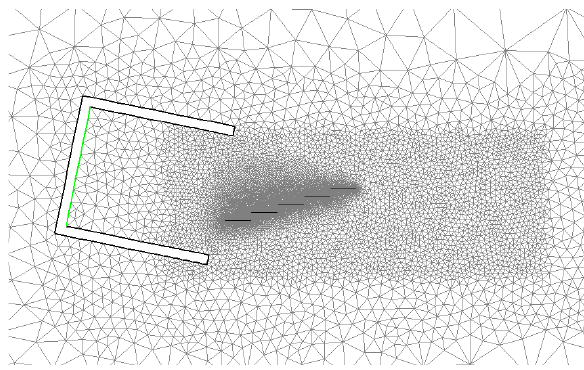
Fig. 3. Computational domain and triangular mesh.